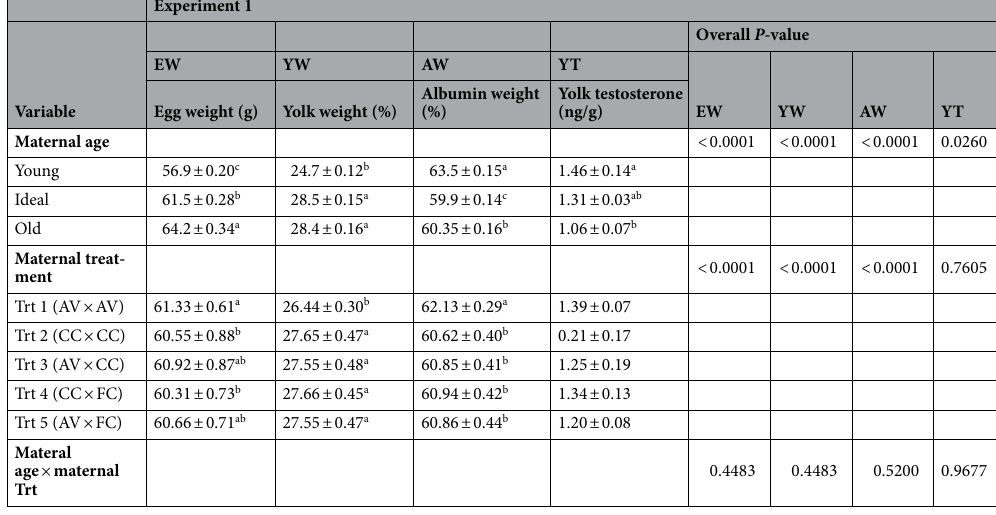
Table 1. Egg composition and yolk testosterone concentration. LSMean ± SEM for egg quality traits, egg composition and yolk testosterone of eggs from hens in Experiment 1 collected at three different ages. abc Values within a column for Maternal Age and Maternal Rearing × Adult Housing treatments with different superscripts differ P <